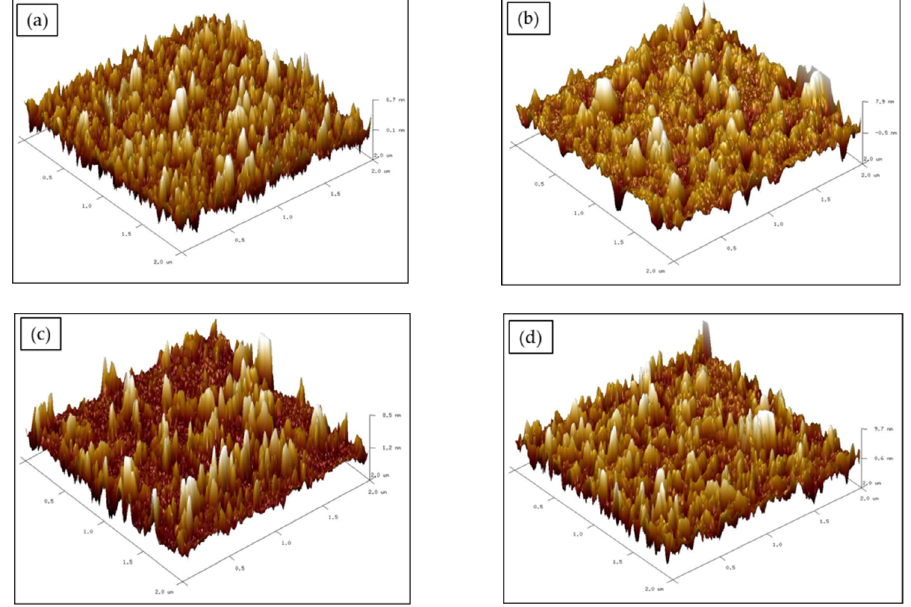
Figure 9. The 3D AFM images: ( a ) GO, ( b ) PVA, ( c ) GO-PVA thin films, and ( d ) GO–PVA thin film in contact with carbaryl.